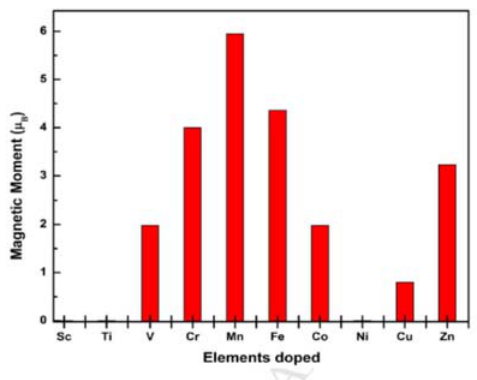
Figure 8. Magnetic moment in SnO 2 lattice doped with different transition metal ions (The Figure was reproduced with copyright permission from reference [29]).